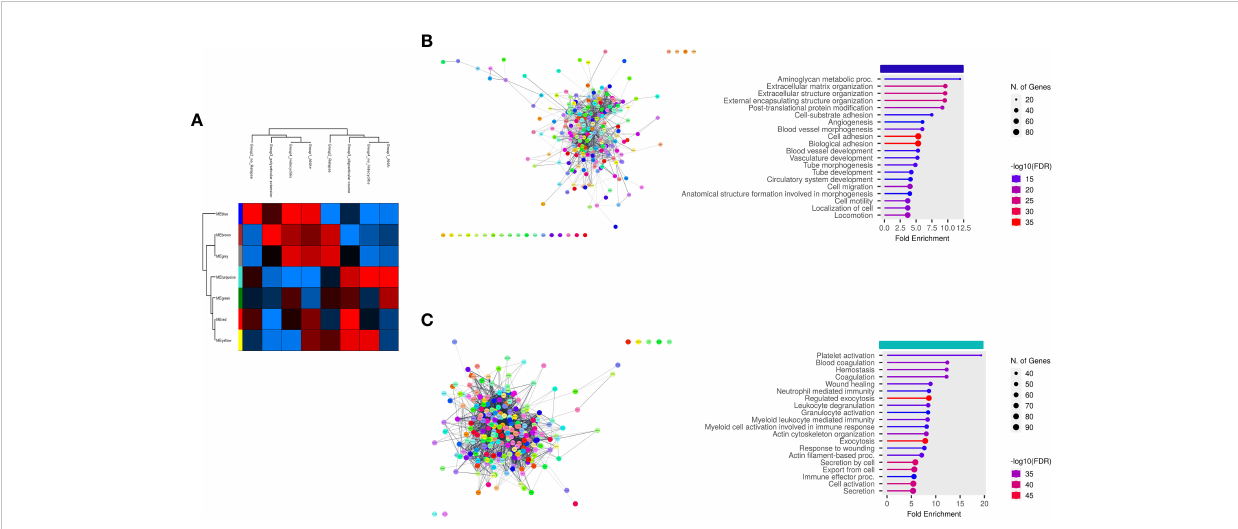
FIGURE 8 Weighted correlation network analysis of EV-prot datasets in PL_OJIA samples. WGCNA was carried out on the 30 PL_OJIA samples to construct Coexpression Modules functionally associated with selected patient clinical and laboratory parameters. (A) Heat-map representation shows the interactive relationships of seven identi fi ed co-expression modules with the four OJIA clinical parameters. Results are indicated as described in the legend of Figure 7A. (B, C) Functional interaction networks and GO biological process enrichment analyses were carried out on selected EV-prot modules. as detailed in the legend of Figures 3C,D. Selected modules are indicated by the horizontal colored bars on top of the graphs showing the most relevant enriched GO terms.